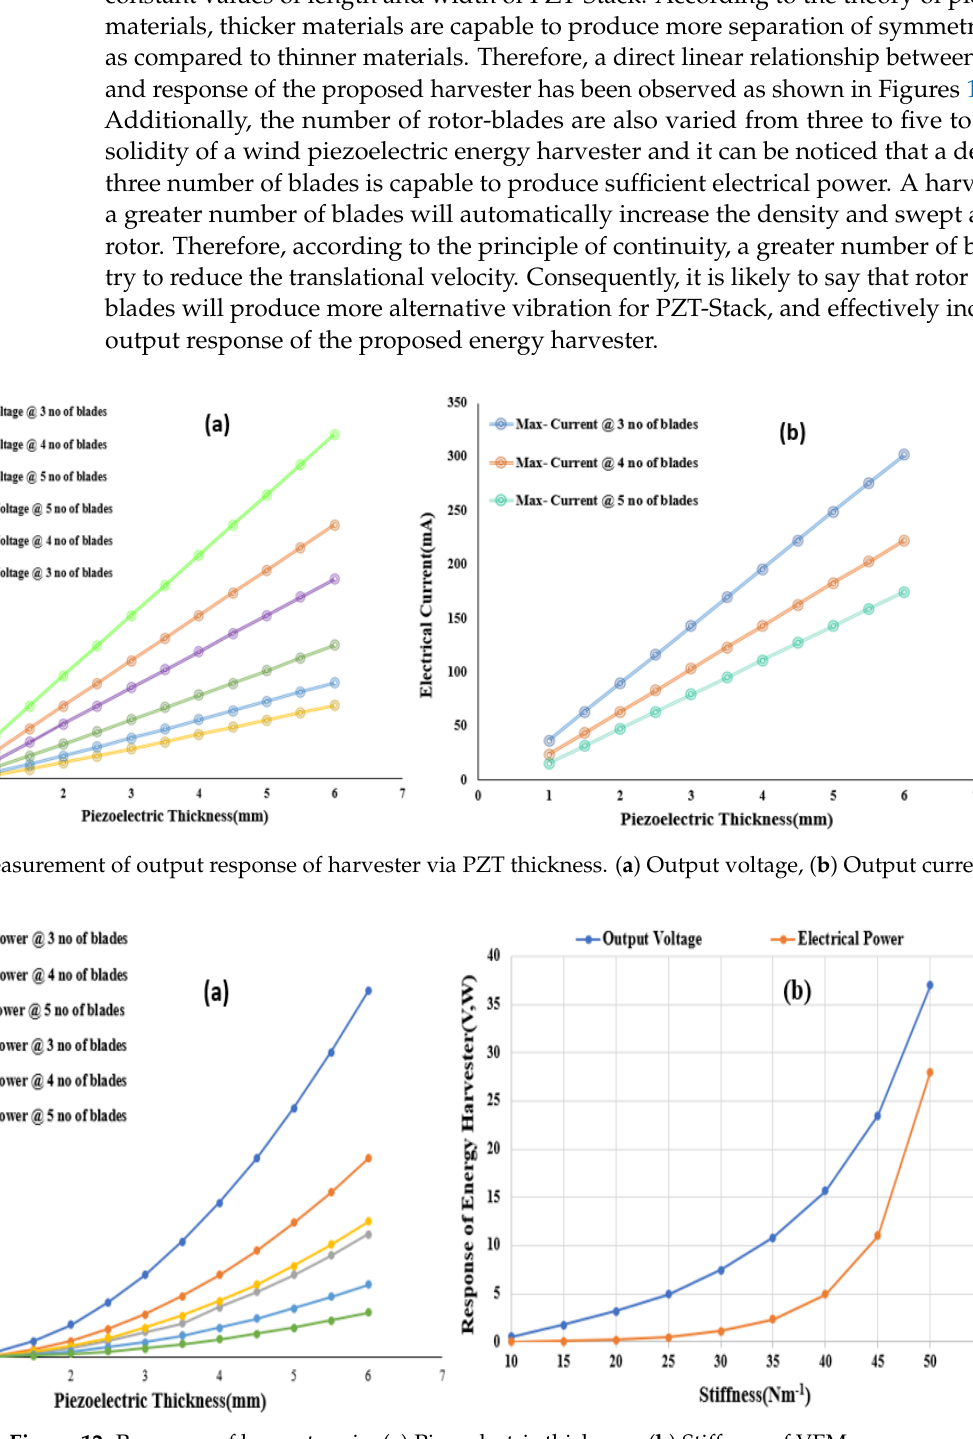
Figure 12. Response of harvester via. ( a ) Piezoelectric thickness, ( b ) Stiffness of VEM.